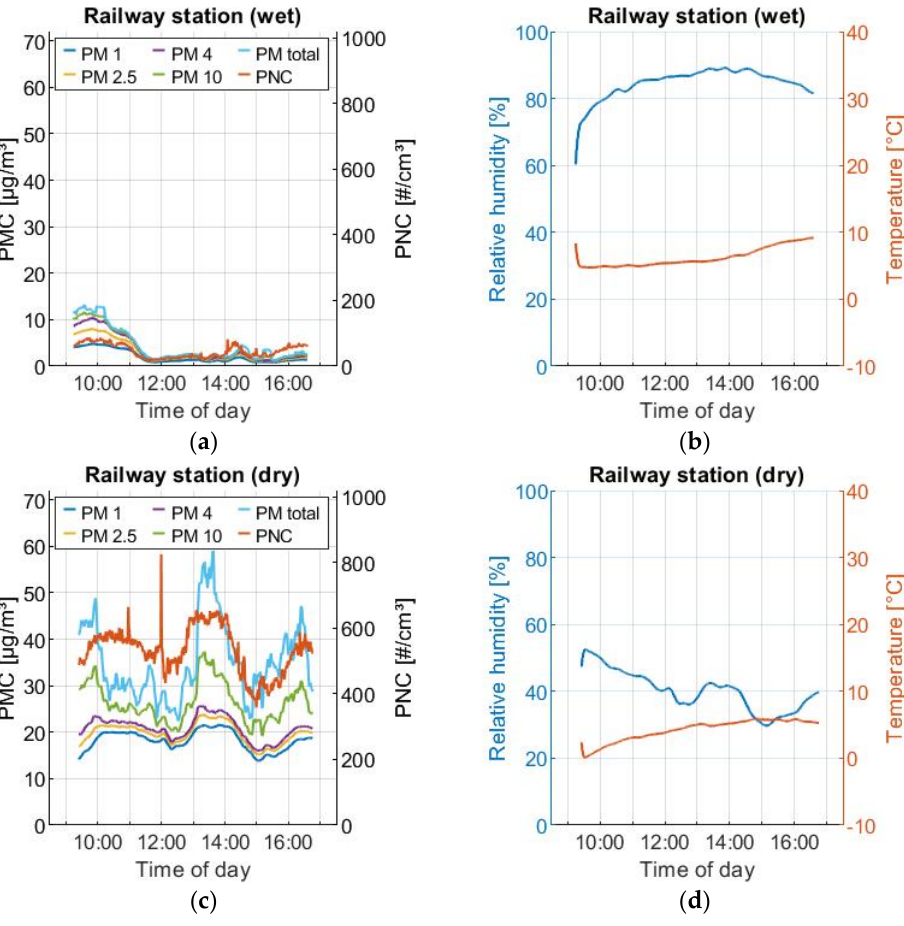
Figure 10. Comparison of the influence of air humidity on PMC and PNC: ( a , b ) influence of high humidity; ( c , d ) influence of low humidity.